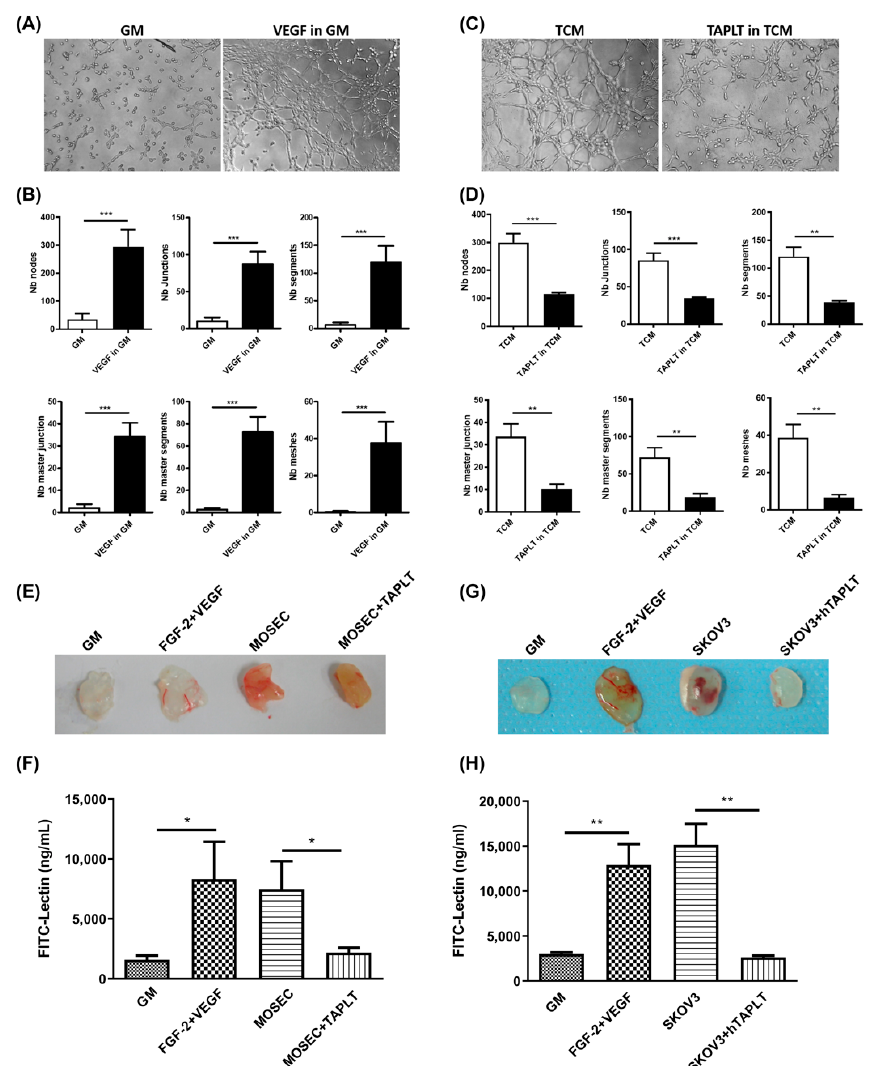
Figure 3. TAPLT inhibit tumor-associated angiogenesis. ( A ) Mouth endothelial cells, 2H11 EC, formed the tube network in solidified Matrigel at 2-h growth in GM in presence or absence of vascular endothelial growth factor (VEGF), respectively used as positive controls and negative controls. Representative images at 100 × magnification were shown. ( B ) Quantitation of panel ( A ) using Image J with the Angiogenesis Analyzer plug-in tool. Mean ± SEM, with a total of three individual experiments. ***: p < 0.001. ( C ) Similar to control panel ( A ), the tube network formation of 2H11 EC in TCM in presence or absence of mouse TAPLT was studied. ( D ) Quantitation of panel ( C ). Mean ± SEM, with a total three individual experiments; **: p < 0.01; ***: p < 0.001. ( E ) The effect of GM alone (“GM”), GM with fibroblast growth factor 2 (FGF-2) and VEGF (“FGF- 2+VEGF”), C57BL/6 murine ovarian surface endothelial cells (MOSEC; “MOSEC”), or MOSEC cells co-administered with TAPLT (“MOSEC+TAPLT”) on neovascularization of in vivo Matrigel plugs was imaged using digital camera. ( F ) Matrigel plugs observed in panel ( E ) was digested for FITC- lectin staining of endothelial cells. The concentration of FITC-Lectin was calculated for neovascular quantitation. Mean ± SEM (n = 9, 8, 12, and 11 respectively for “GM”, “FGF-2+VEGF”, “MOSEC”, and “MOSEC+TAPLT”). *: p < 0.05. ( G ) Similar to panel ( E ), the effect of GM, FGF-2+VEGF, and human TAPLT+SKOV3 (human ovarian adenocarcinoma cells) on neovascularization was recorded by images. ( H ) Quantitation of neovascularization in Matrigel plugs of panel ( G ). Mean ± SEM (n = 4 for all conditions). **: p < 0.01. All comparisons were two-group comparisons ( t -test) as